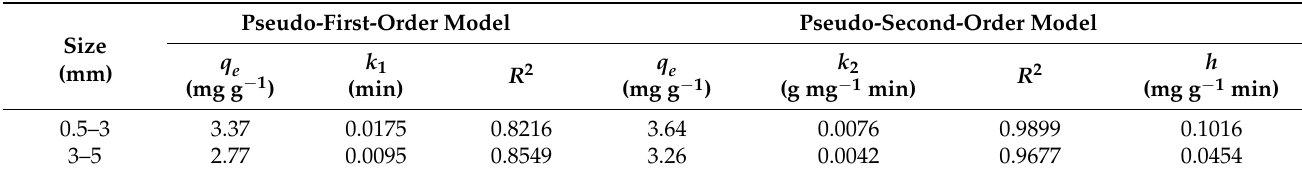
Table 3. Adsorption kinetic parameters of nitrogen onto zeolite.